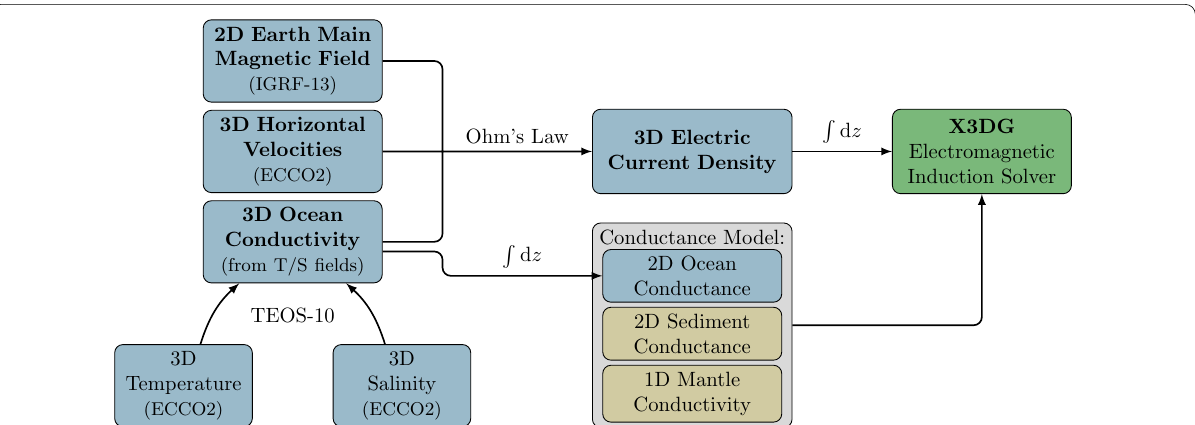
Fig. 1 Sketch of the processing steps for the input of the electromagnetic induction solver X3DG used in this study. Note: blue boxes highlight quantities, which are updated each time step